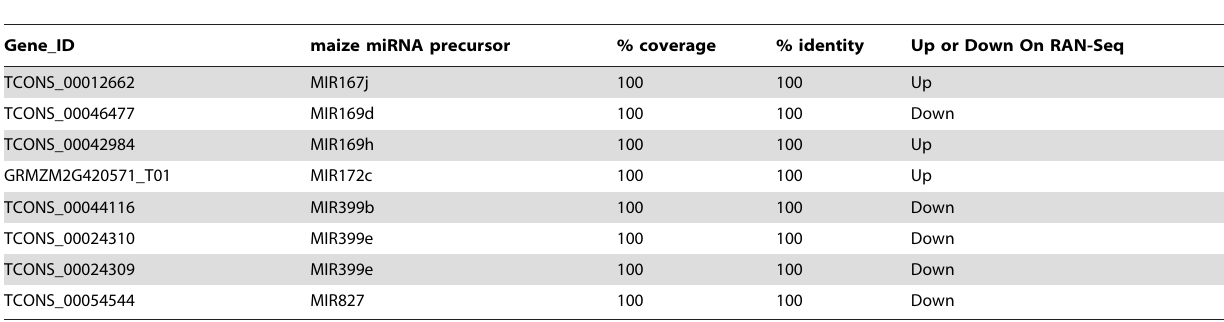
Table 2. The lncRNAs were identified as miRNA